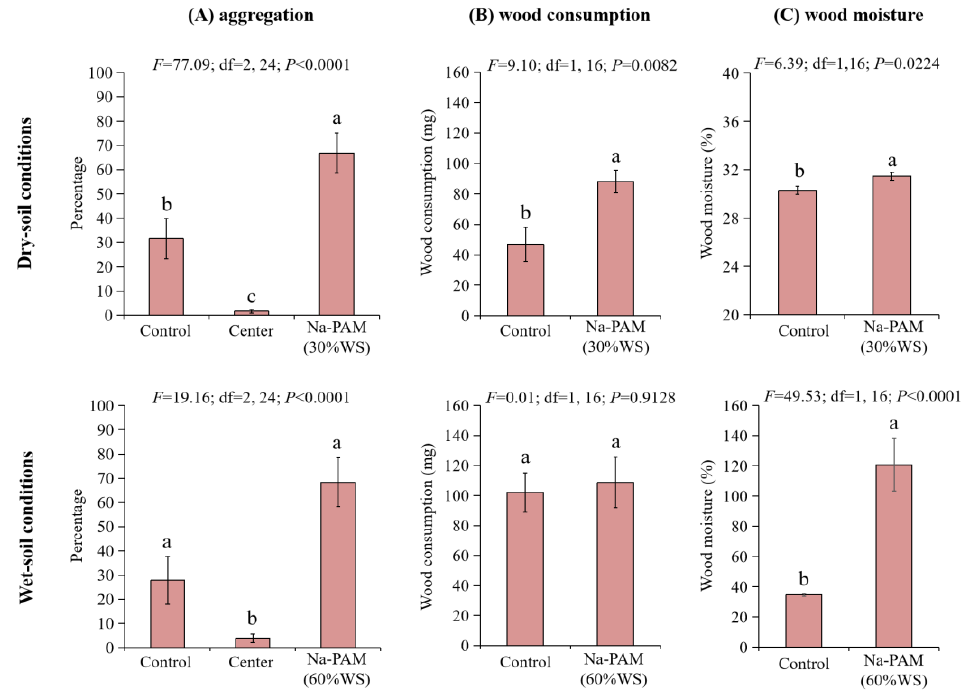
Figure 3. Results of the two-choice tests (under dry- or wet-soil conditions) to investigate the preference of termites to sodium polyacrylate (Na-PAM) placed within soil. Percentage of termites in each chamber ( A ), and wood consumption ( B ) and wood moisture ( C ) in the side chambers are presented as mean ± SE. Different letters indicate significant differences ( p < 0.05). WS represents water saturation level.